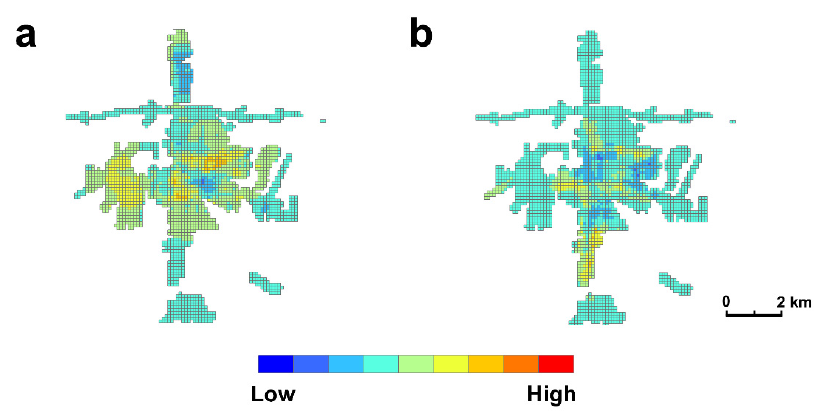
Figure 3. Differences between male and female respondents’ judgment of ( a ) safe and ( b ) unsafe places. Higher values indicate more male, lower values indicate more female markings. Example city: Nagykanizsa.